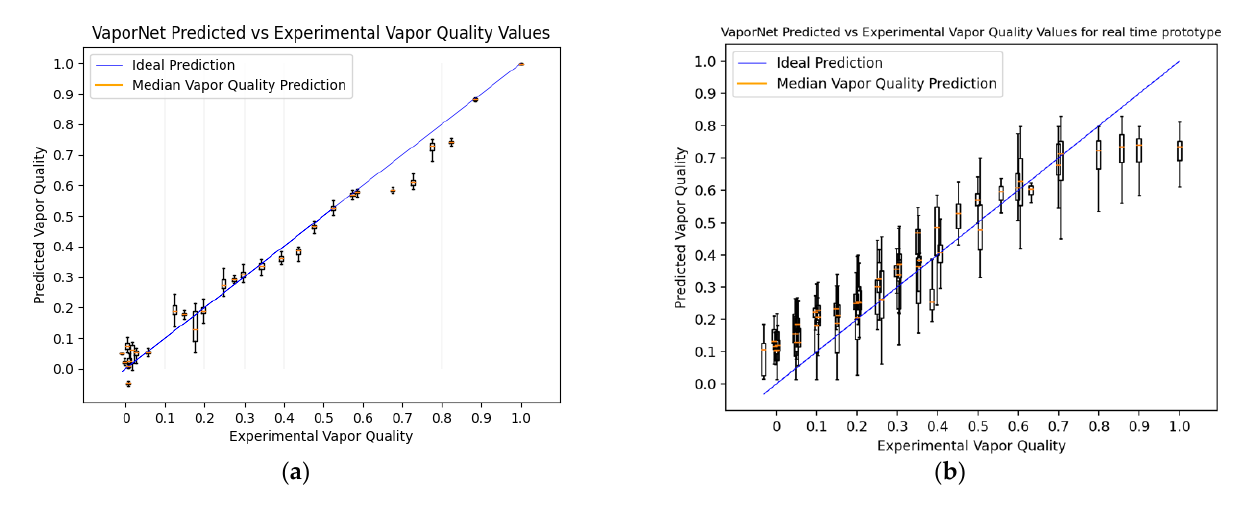
Figure 8. VaporNet predicted values vs. experimental values: ( a ) using offline data processing; ( b ) deployed on the laboratory prototype, collecting live data. Table 2. Findings of the 5-fold test results, with best results in bold.